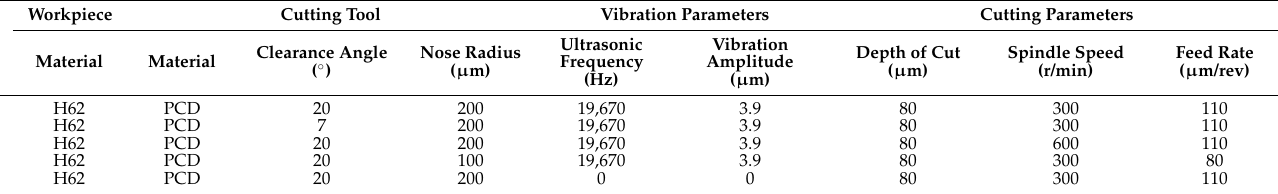
Table 1. Processing parameters used for preparing surfaces.